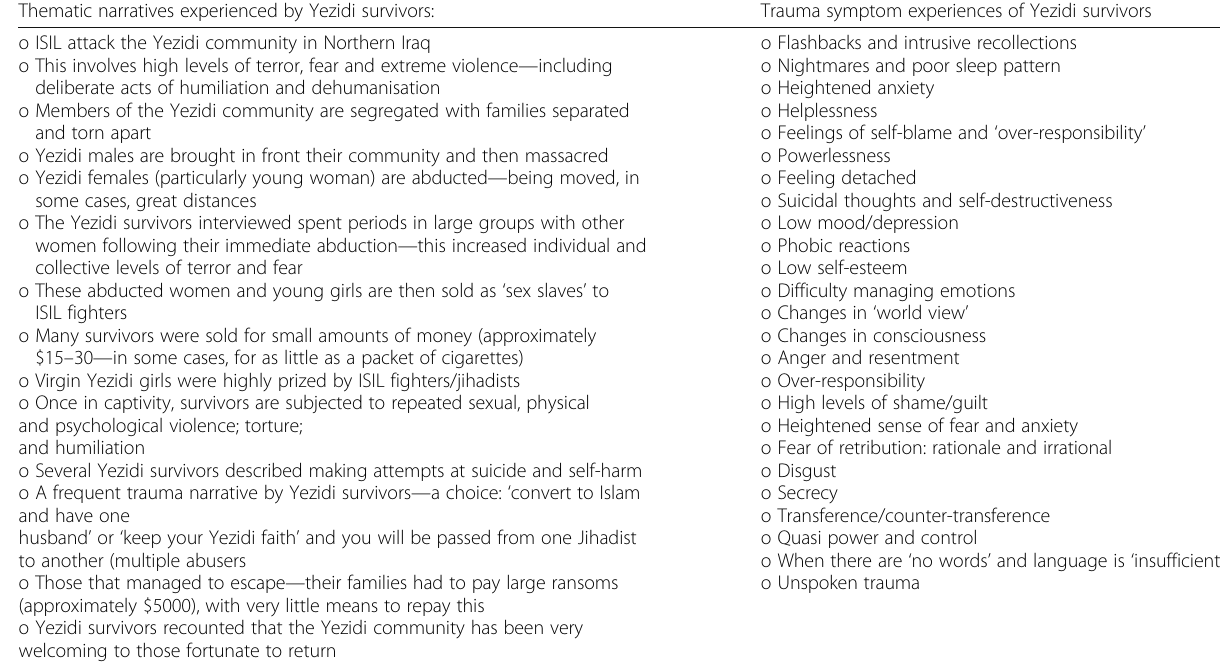
Table 1 Pattern of trauma experiences and symptoms encountered by six female Yezidi survivors rescued from ISIL Thematic narratives experienced by Yezidi